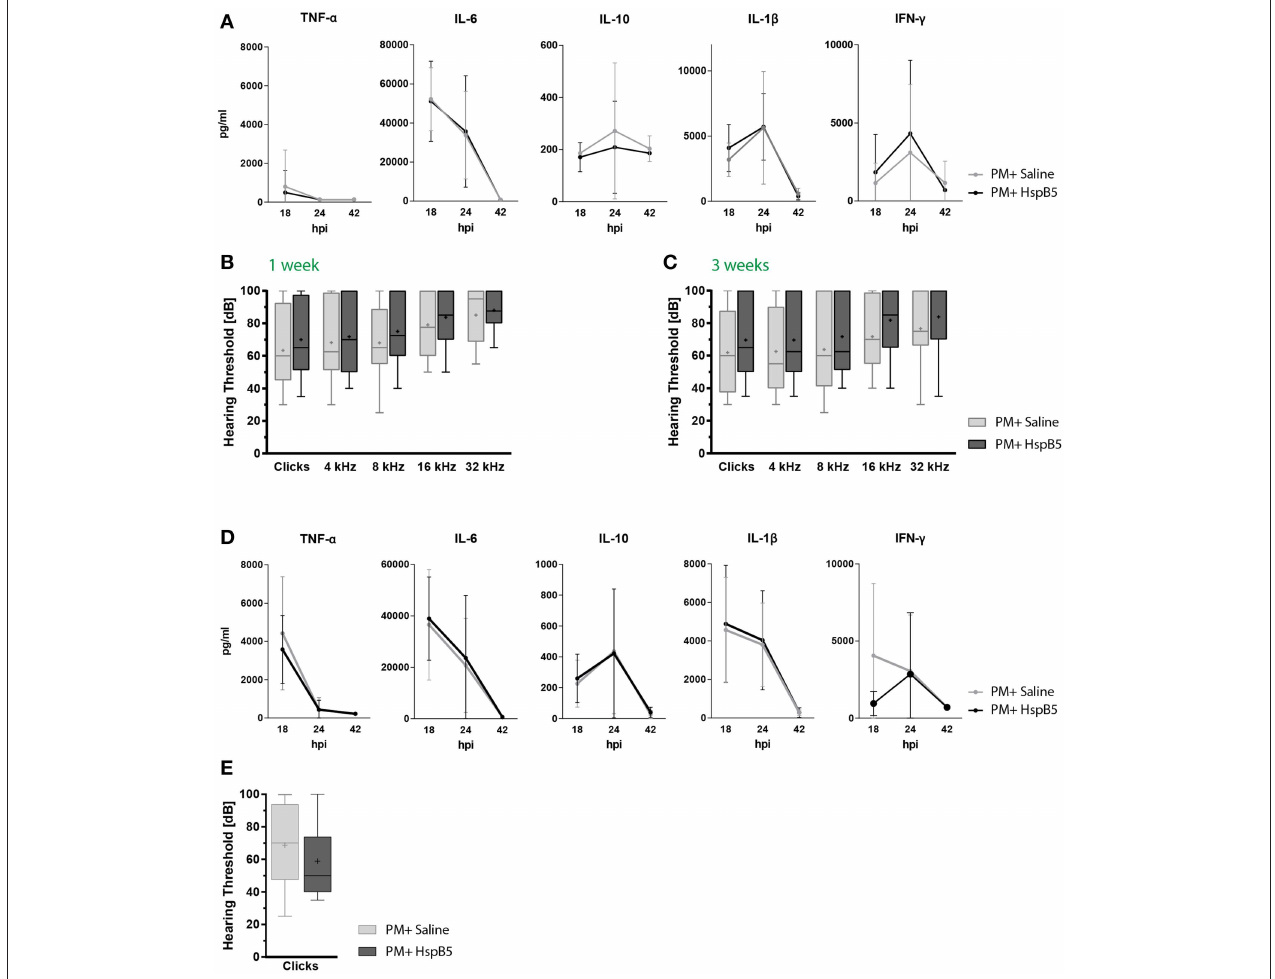
FIGURE 6 | Intraperitoneal administration of HspB5 does not change inflammatory cytokine profiles nor hearing thresholds. (A) Animals received a single HspB5 i.p. injection at 18hpi. Quantification of inflammatory cytokines in the CSF at 18, 24, and 42h post infection; untreated ( n = 9, gray) and HspB5-treated ( n = 10, black) (B) Animals received a HspB5 i.p. injections at 18hpi, 3 days, and 5 days post infection. ABR hearing thresholds for clicks and pure tones 1 week and (C) 3 weeks post infection; untreated ( n = 26 ears/13 animals, gray) and HspB5-treated ( n = 26 ears/13 animals, black). (D) Animals received i.p. injections 2h prior to infection, as well as at 18 hpi. Quantification of inflammatory cytokines in the CSF at 18, 24, and 42h post infection; untreated ( n = 11, gray) and HspB5-treated ( n = 10, black) (E) Animals received i.p. injections 2h prior to infection, as well as at 18 hpi, 3 days, and 5 days post infection. ABR hearing thresholds for clicks 4 weeks post infection; ( n = 28 ears/14 animals, gray) and HspB5-treated ( n = 24 ears/12 animals black). Box and whisker plot quartiles from min-max. Graphs show mean values with standard deviation. Statistical differences were assessed by single comparison using unpaired t -test and two-way